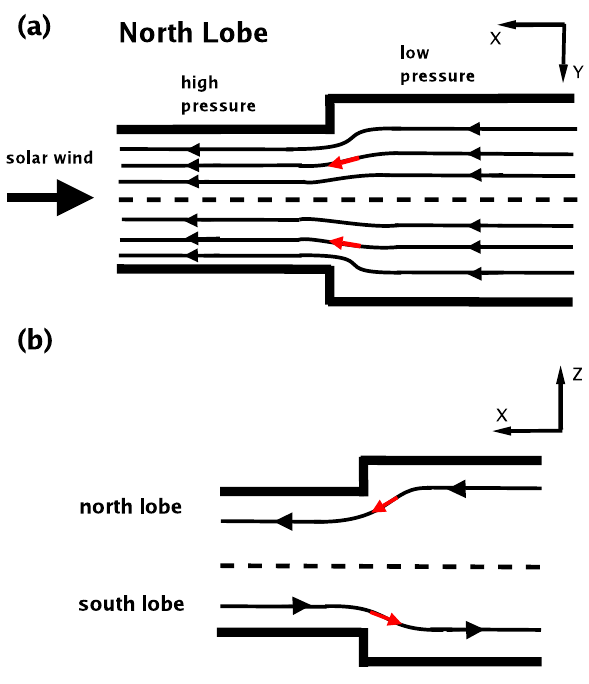
Fig. 5. Sketch of the step-like compression in the XY and XZ planes. Thin lines represent the magnetic field lines and the thick solid lines represent the tail boundary. Panel ( a ) shows compression in the north lobe XY plane and panel ( b ) shows compression in the XZ plane.